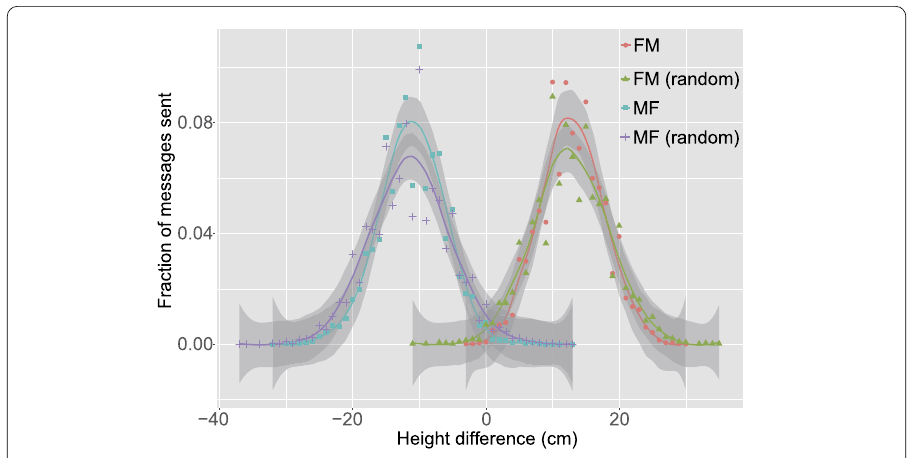
Figure 2 Height difference distribution. FM represents that female users send messages to male users and MF represents that male users send messages to female users. Solid lines represent the locally weighted polynomial regression fitting of their corresponding data points, and the gray interval represents a 95% confidence